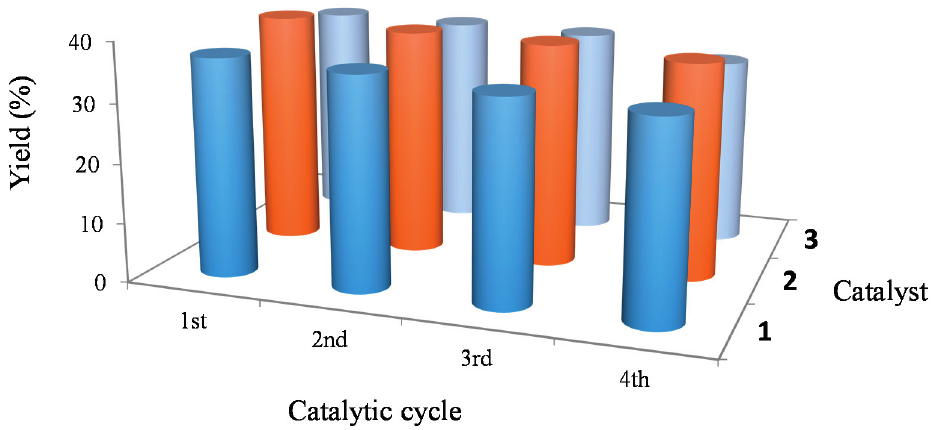
Figure 5. Effect of the catalyst recycling on the overall yield of the products from the cyclohexane oxidation catalyzed by 1 – 3